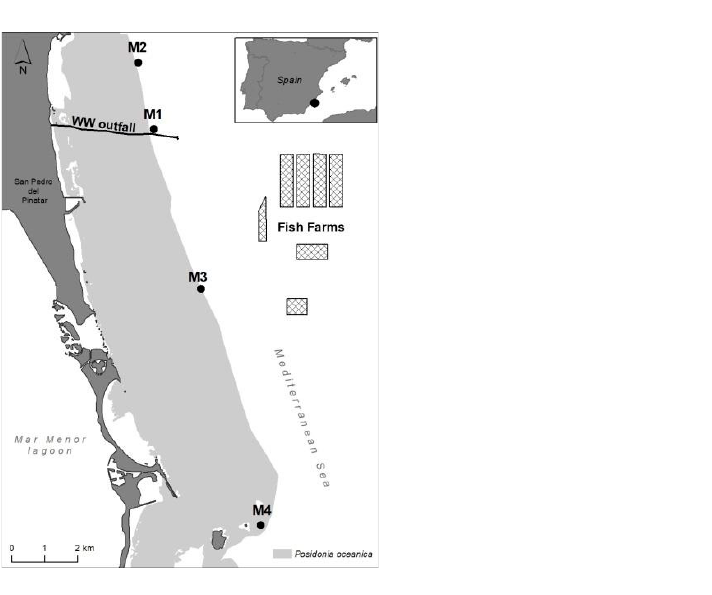
Figure 8. Study area showing the four sampling sites (M1–M4) along the deep margin of an extensive P. oceanica meadow. The seagrass distribution is shown in grey. The black line indicates the underwater outfall through which effluent wastewater treatment is discharged off-shore (WW) while the cages represent the facilities of the fish farm complex (FF).